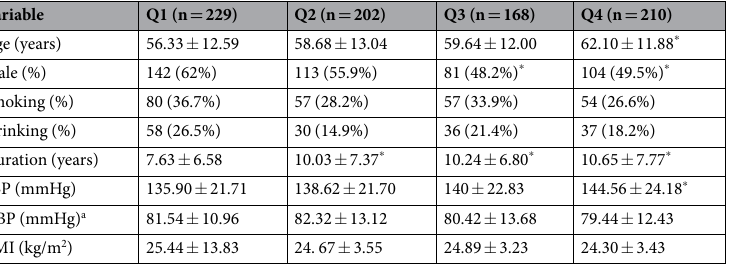
Table 1. Distribution of basic characteristics from Q1 to Q4 in T2D patients. Notes: The analysis of variance (ANOVA) was used to compare the distribution of the variables when follows normal distribution, if not, the non-parametric Kruskal-Wallis test was applied; χ 2 test was used to compare the difference of qualitative variables; a Indicates the variables did not follow normal distribution. * Statistical P value < 0.05 compared to Q1.